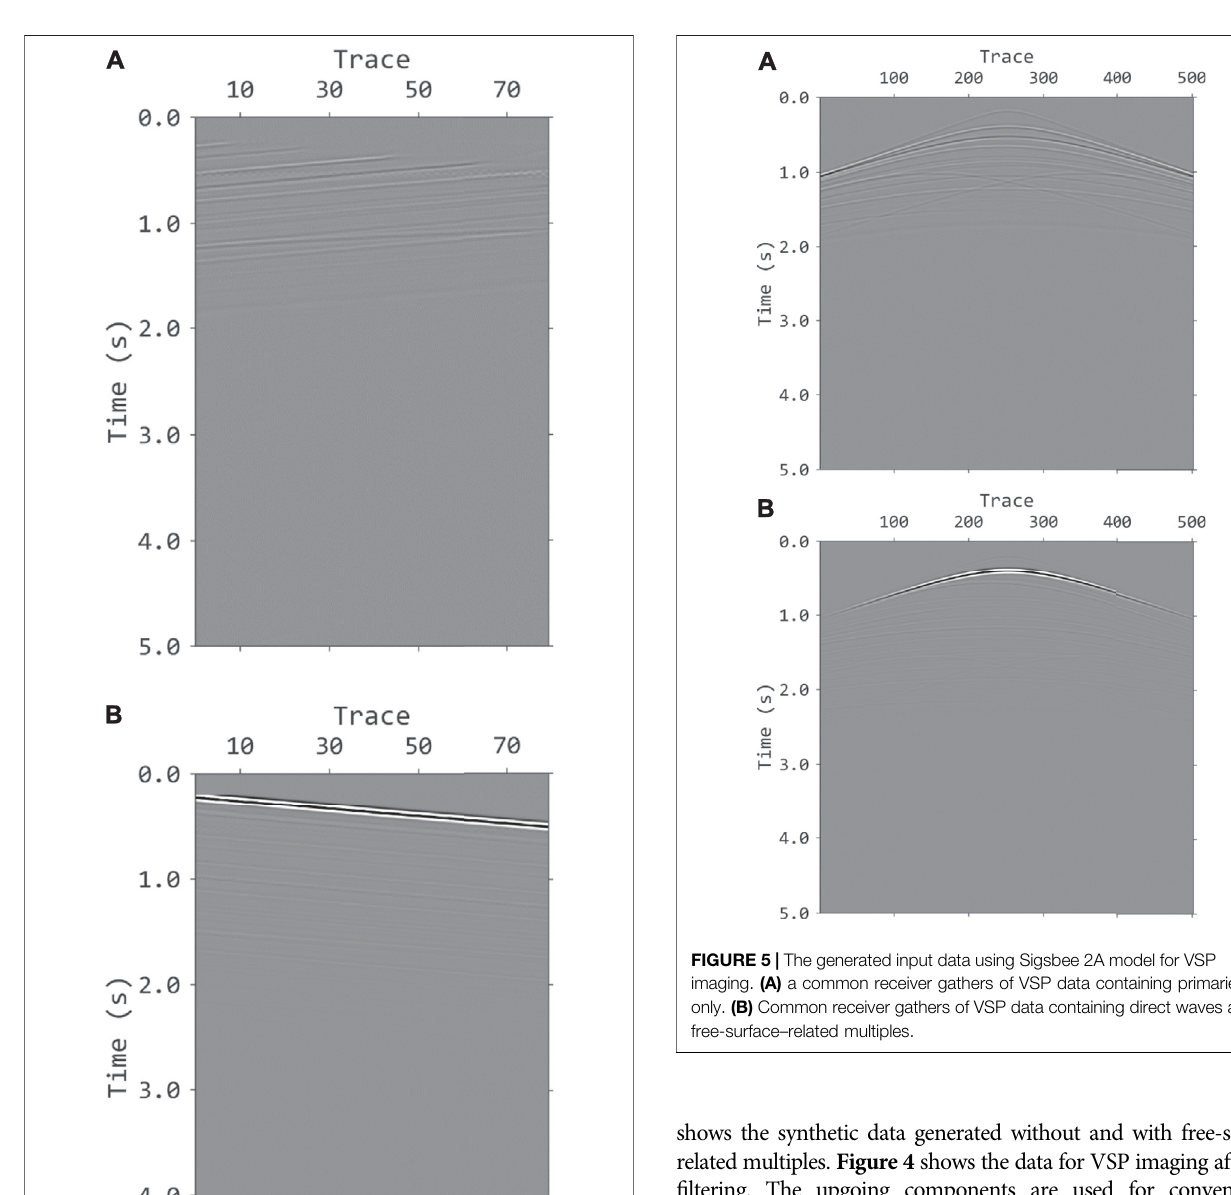
model. Figure 2 shows the velocity model. 500 shots are deployed on the surface and 80 geophones are placed evenly in the observation well located at the center of the model. The time sampling interval is 1 ms and the grid spacing of the model is 10 m. A Ricker wavelet with peak frequency of 15 Hz is used as the source wavelet. Figure 3